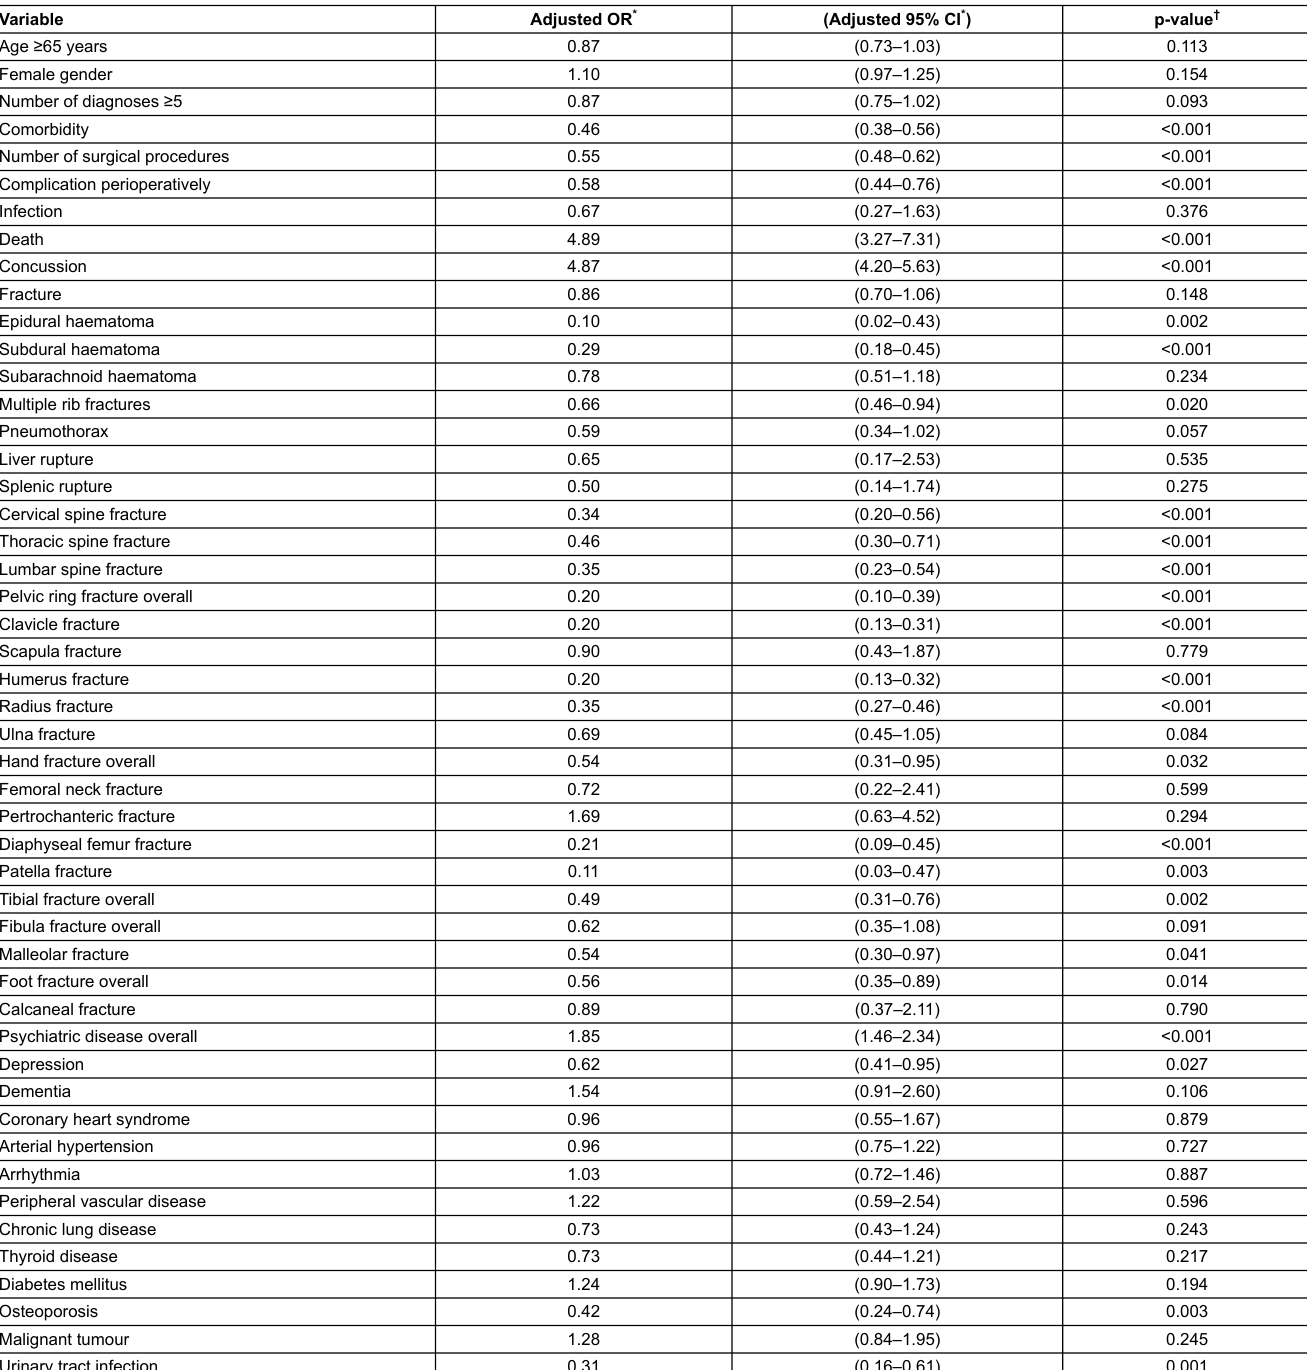
Table 5: Logistic regression model for factors associated with shorter LOS outliers regarding length of hospital stay (LOS) (n = 6250).